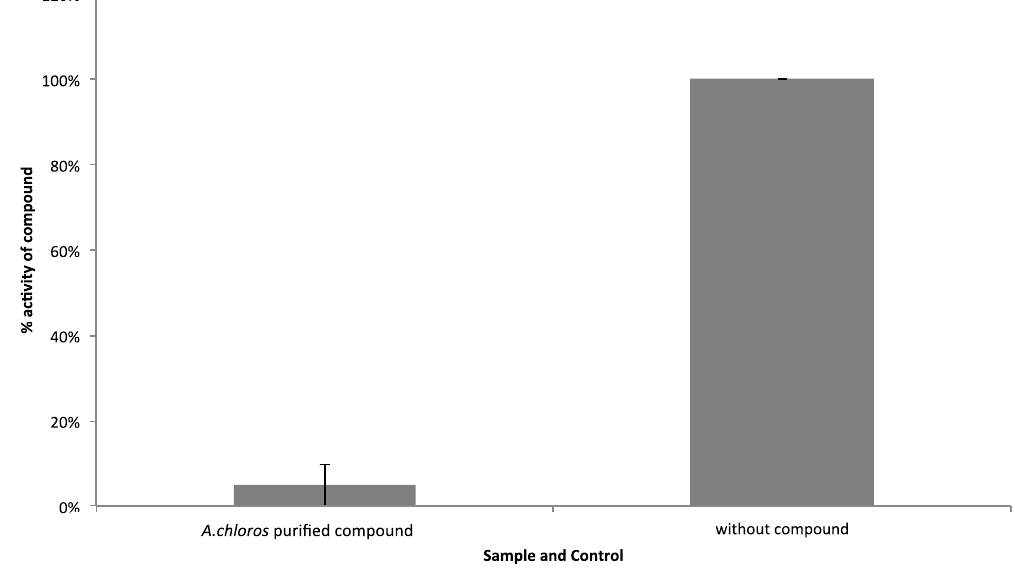
Figure 4. Effect of the purified 3-alkylpyridinium compound 1 from A. chloros on WNV NS3 protease activity. Error bars denote standard deviations.